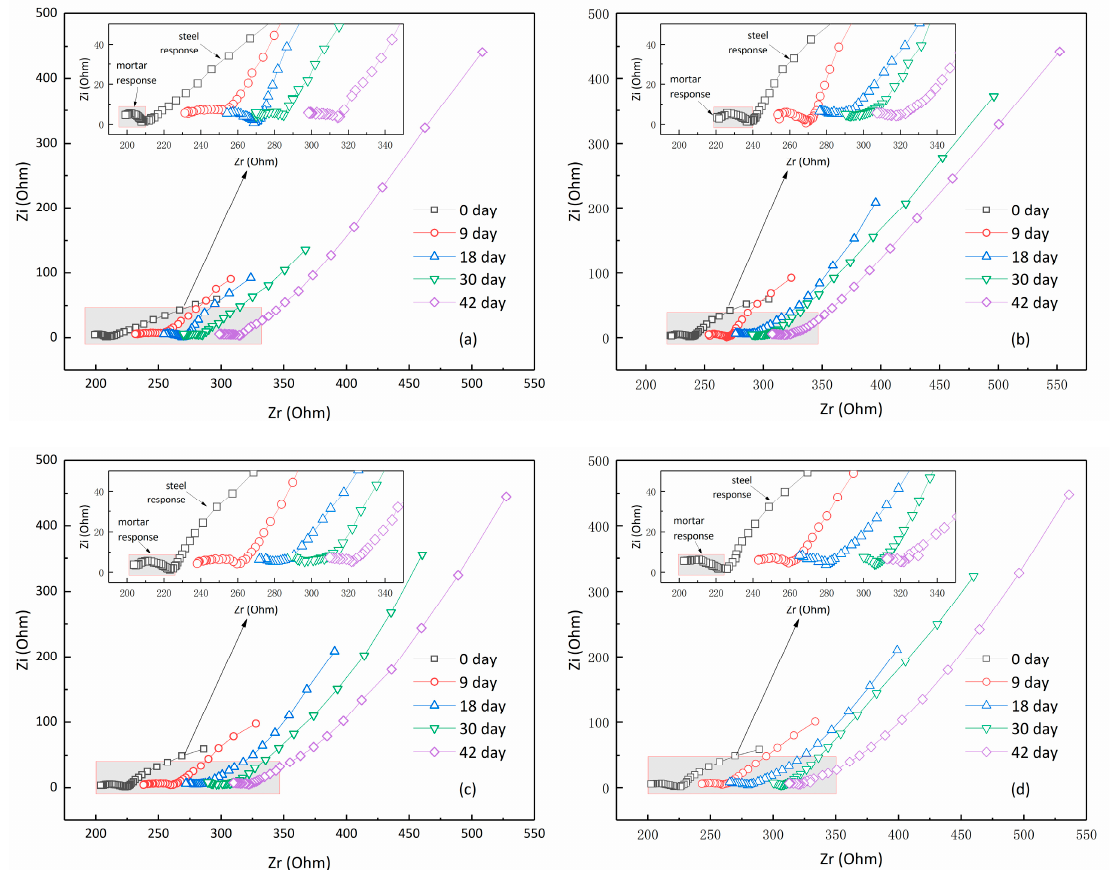
Figure 7. Nyquist spectra at different times. ( a ) Without ultrasound; ( b ) 40 Hz/60 W ultrasound; ( c ) 40 Hz/50 W ultrasound; ( d ) 17 Hz/50 W ultrasound.